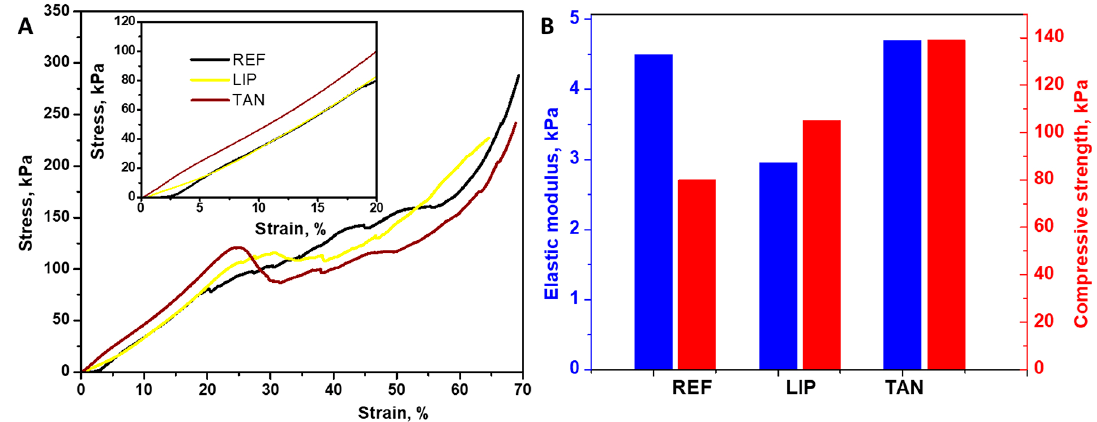
Figure 4. ( A ) Representative compressive stress-strain curves for REF, LIP and TAN at room temperature; ( B ) The values of the elastic modulus and compressive strength for the obtained biomaterials. Table 2. Dynamic vapors sorption (DVS) parameters for the obtained biomaterials.